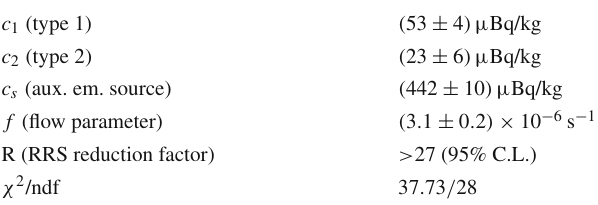
Table 1 Parameters obtained from fitting the rate equation model, Eq. (9) (a–c), to phases V–VII